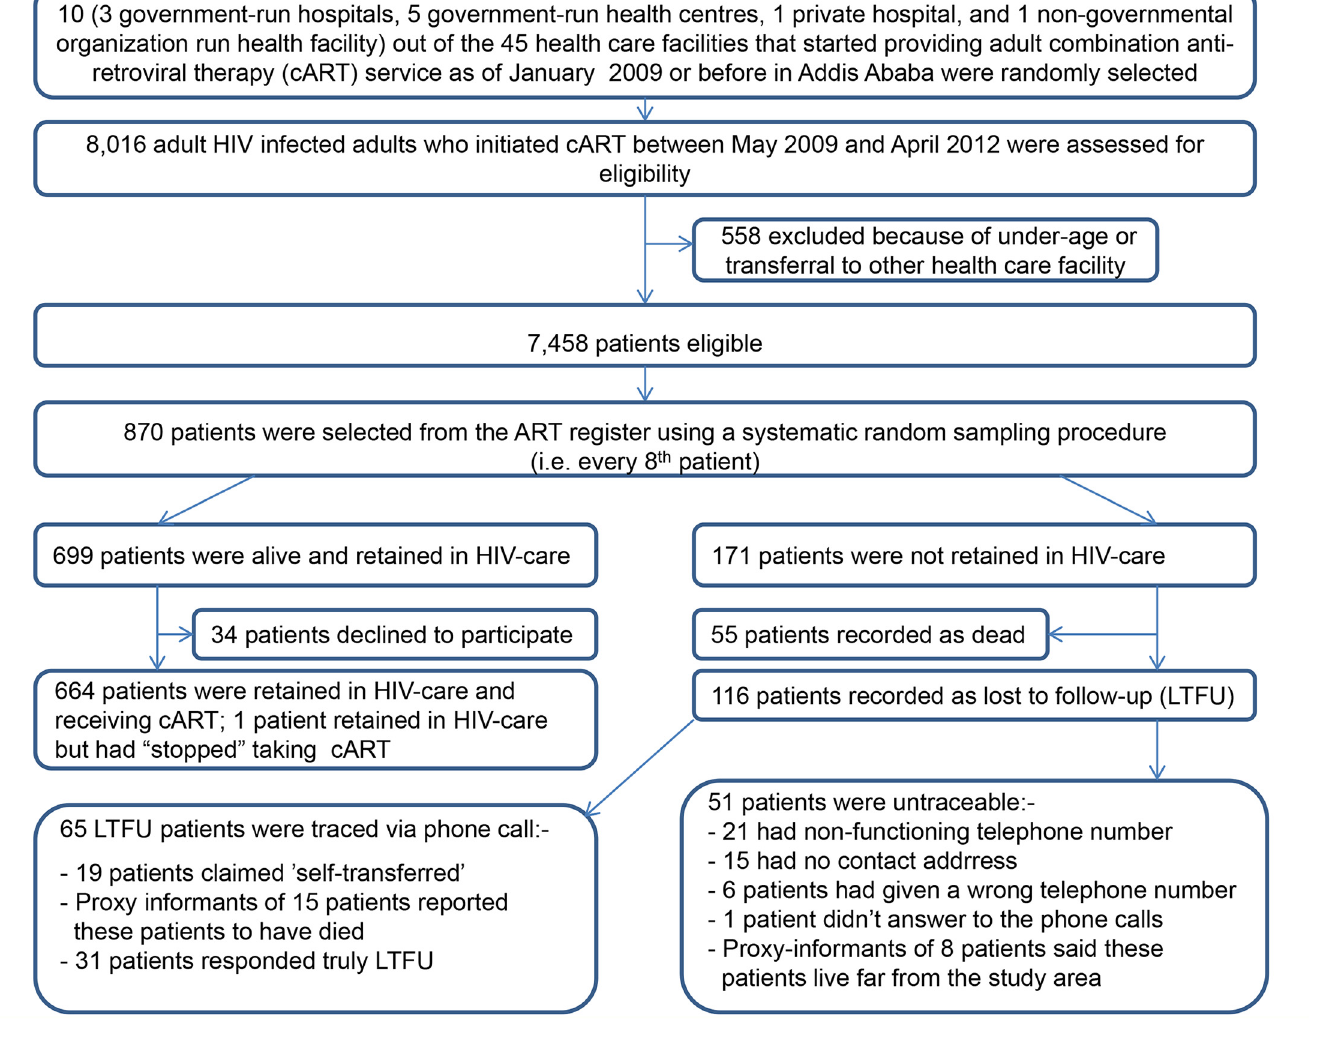
Fig 1. Flowchart depicting the random selection of health care facilities and patients included in the